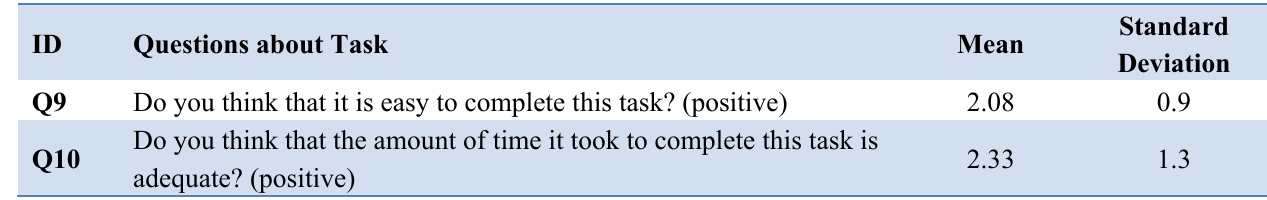
Table 4. Statements, mean and standard deviation for the third part of the questionnaire.